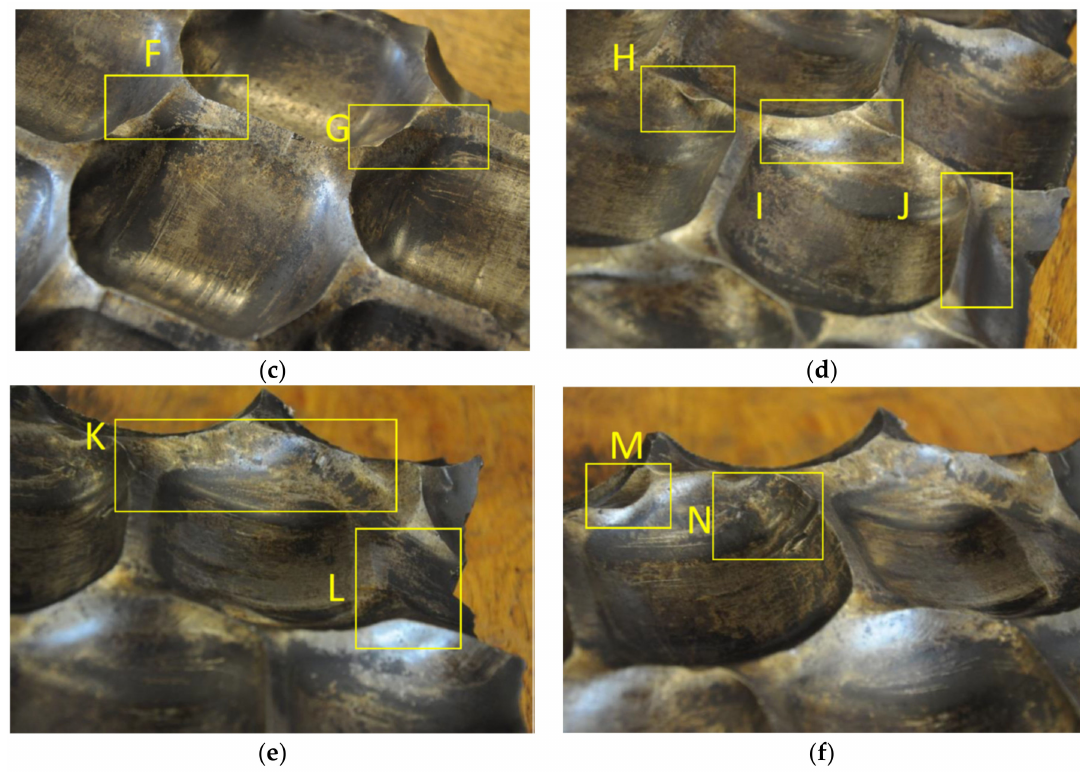
Figure 9. Ring surface topography. ( a , b ) First row; ( c , d ) Third row; ( e , f ) Fifth row.